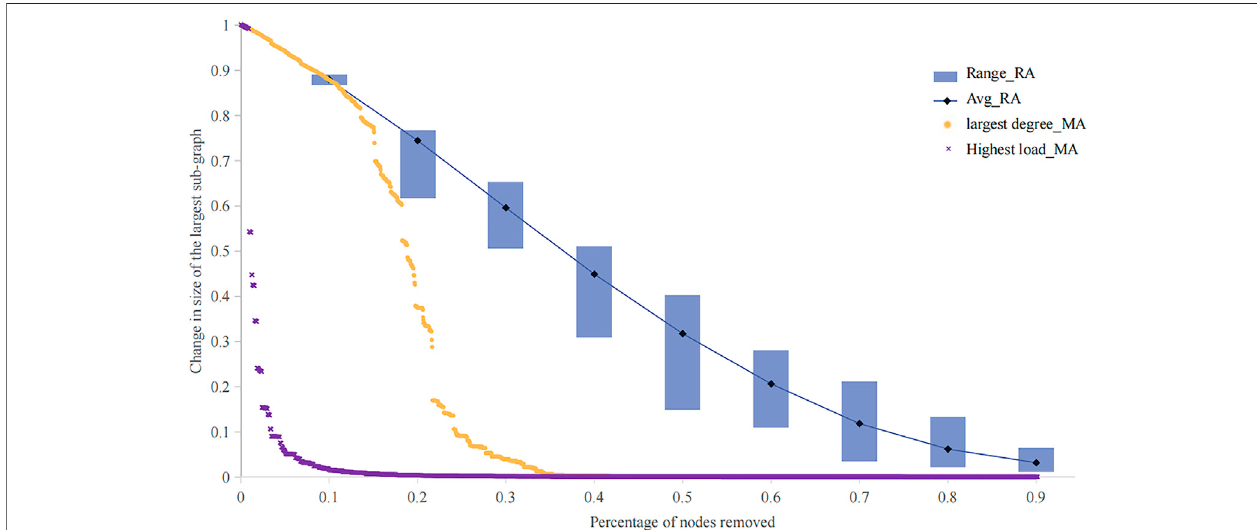
FIGURE 3 | Connectivity robustness of the electric network under random attacks (RA) and malicious attacks (MA). The random attack is simulated by randomly removing 10%, 20%, 30%, 40%, 50%, 60%, 70%, 80%, and 90% of nodes from the network. The range shows the results of 100 simulations, and the black point representstheaveragevalueofchangesinthesizeofthelargestcomponentsunderRA.MAaresimulatedbyremovingthenodewiththelargestdegree(yellow)andthe highest load (violet) until 90% of the nodes are removed from the network.